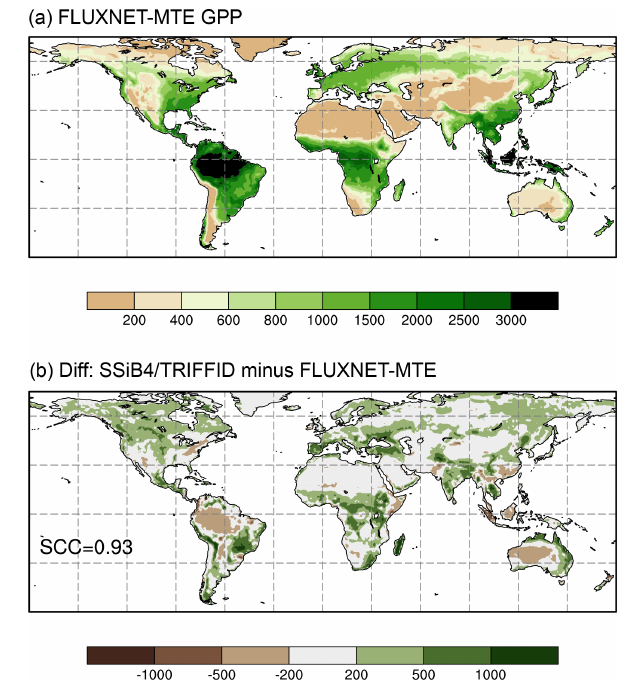
Figure 5. The 1982–2007 average gross primary production com- parison for (a) FLUXNET-MTE GPP and (b) difference between SSiB4/TRIFFID and FLUXNET-MTE GPP. SCC indicates the spa- tial correlation